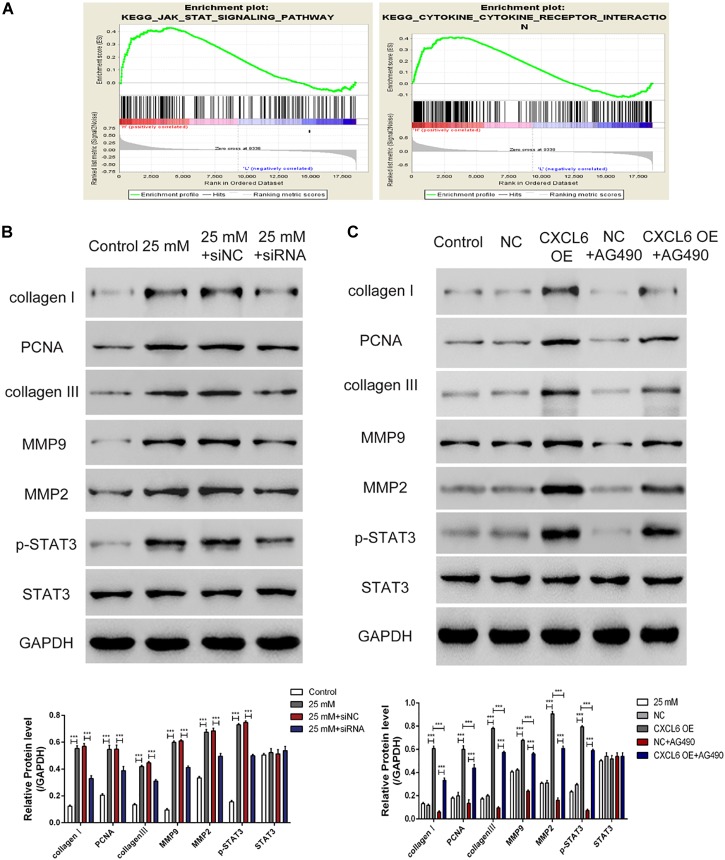
CXCL6-associated pathways in DN. (A) GSEA was performed using GEO DataSets (Asscess ID: GSE28221). The JAK/STAT and CYTOKINE _CYTOKINE _RECEPTOR _INTERACTION pathways were identified with the strongest association with CXCL6 expression. (B,C) Key moderators were determined by western blotting. Data were based on at least three independent experiments, and shown as mean ± SD. ∗∗∗P < 0.001.